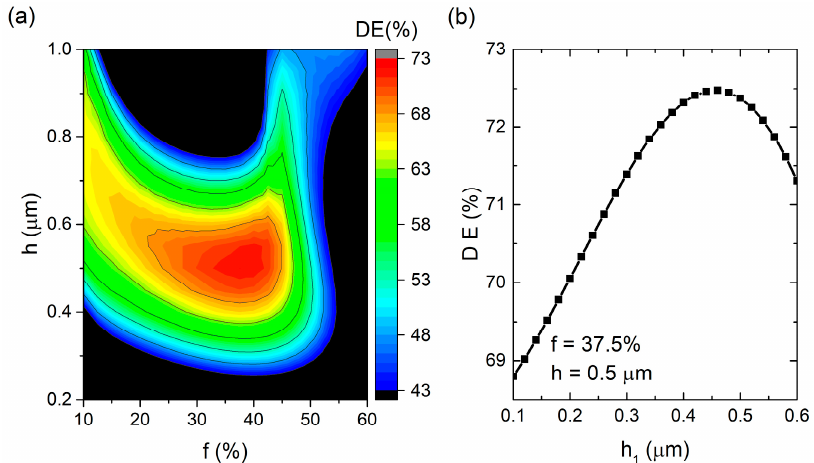
Figure A1. ( a ) Calculated GaAs diffraction efficiency (DE) as a function of groove depth h and filling factor f , with h 1 = 530 nm-thick SiO 2 ARC and ( b ) diffraction efficiency versus SiO 2 ARC thickness ( h ) , at λ p = 3.0 µ m, d = 2.4 µ m, and 3 THz phase-matching